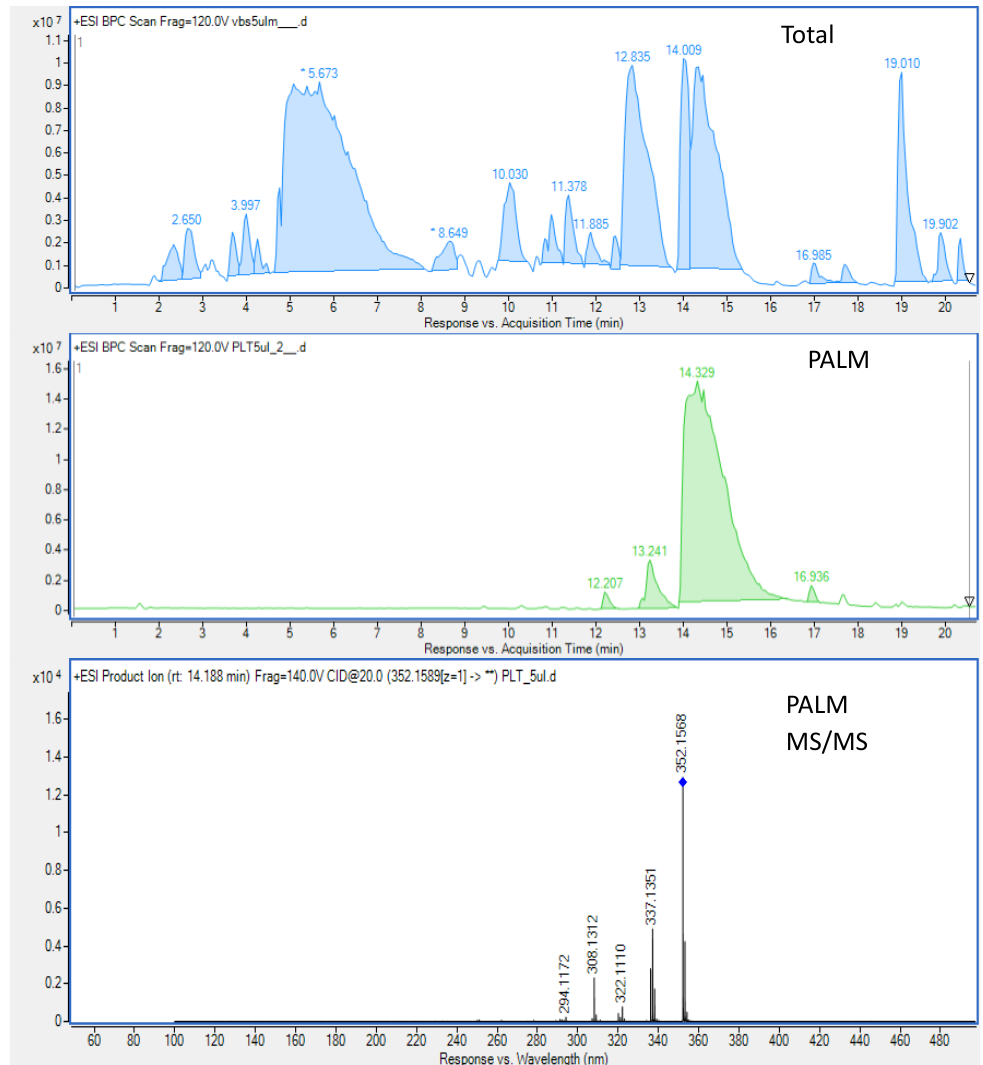
Figure 2. The composition of the total extract, purified palmatine (PALM), and its MS/MS spectrum (PALM MS/MS).